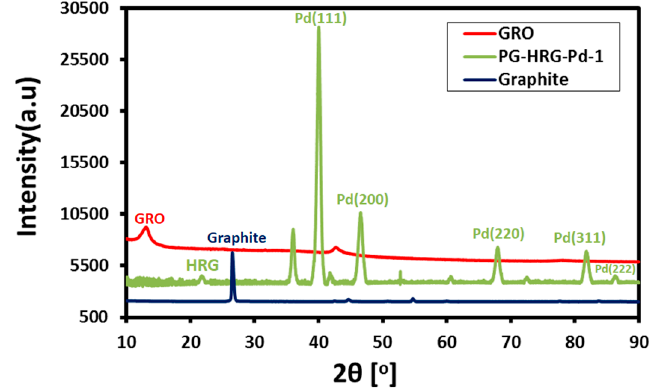
Figure 4. XRD (X ‐ ray diffraction) diffractograms of graphite, graphene oxide (GRO), and plant extract-mediated Pd@graphene nanocatalyst